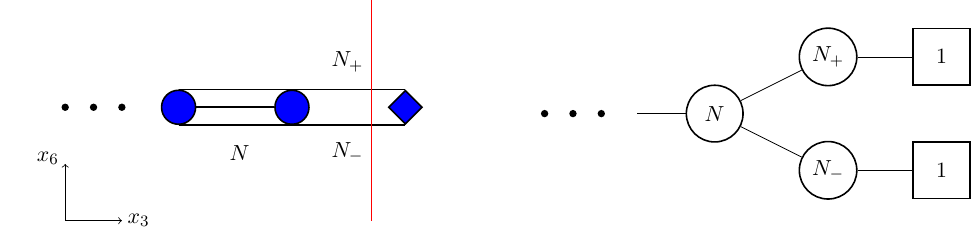
Figure 54 . Type IIB configuration for a bifurcated tail of a D -type quiver with an additional D5-brane (denoted by a red vertical line). The associated 3d quiver is shown on the